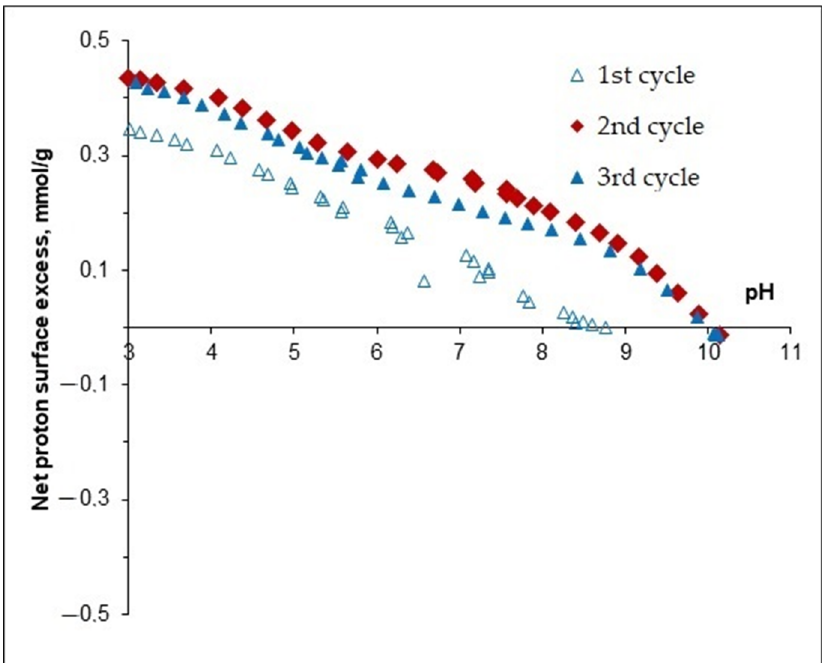
Figure 1. pH-dependent surface charging of Fe 3 O 4 /APTES at different 0.005 M KCl concentrations. The experimental points were calculated from the material balance of H+/OH − during equilibrium acid-base